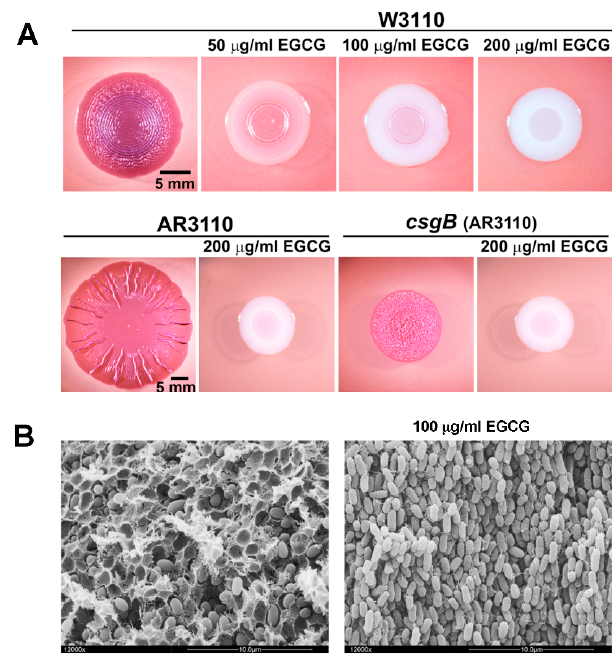
Figure 1. Epigallocatechin-3-gallate (EGCG) prevents the formation of amyloid curli fibres and pEtN-cellulose; i.e., the two major components of the extracellular matrix of macrocolony biofilms of E. coli . ( A ) Macrocolony biofilms of the standard E. coli K-12 strain W3110 (which produces only curli fibres), its derivative strain AR3110 (which produces curli fibres and pEtN-cellulose) and the csgB mutant derivative of strain AR3110 (which produces only pEtN-cellulose) were grown on salt-free complex medium agar plates for five days at 28 °C. Plates were supplemented with Congo red (which binds to and stains curli fibres as well as pEtN-cellulose fibrils) and the indicated concentrations of EGCG, which results in a white colour indicating an absence of the polymeric matrix components. Note that colony wrinkling patterns show characteristic differences depending on whether the matrix consists of the curli/pEtN-cellulose composite or of either component alone. ( B ) High-resolution scanning electron micrographs show tight surrounding of E. coli cells by the composite curli/pEtN–cellulose matrix inside a macrocolony biofilm of strain AR3100 (left panel), whereas no matrix is present with EGCG during growth (right panel). The few filamentous structures visible in the right panel are flagella, which are una ff ected by EGCG. The photographs shown here were previously published [80] under